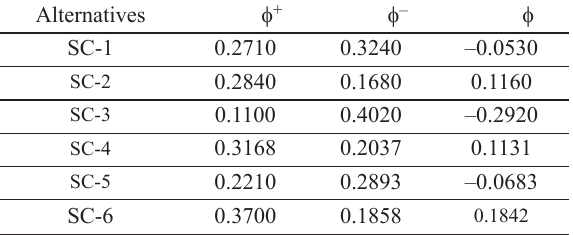
Fig. 2. PROMETHEE II complete